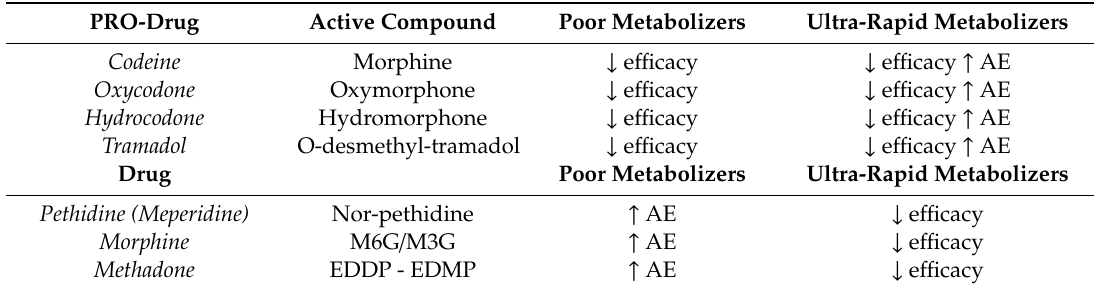
Table 1. Expected di ff erent response to opioid therapy in patients with di ff erent gene phenotype. PRO-Drug Active Compound Poor Metabolizers Ultra-Rapid Metabolizers Codeine Morphine Oxycodone Oxymorphone Hydrocodone Hydromorphone Tramadol O-desmethyl-tramadol Poor Metabolizers Ultra-Rapid